Question: Which visualization type does this figure use?
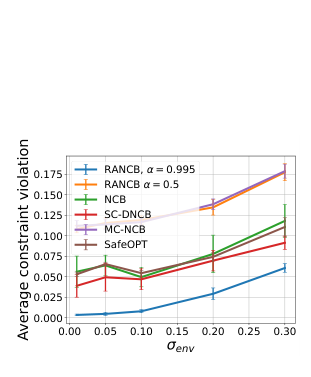
Answer: line